Question: Write the caption for this figure.
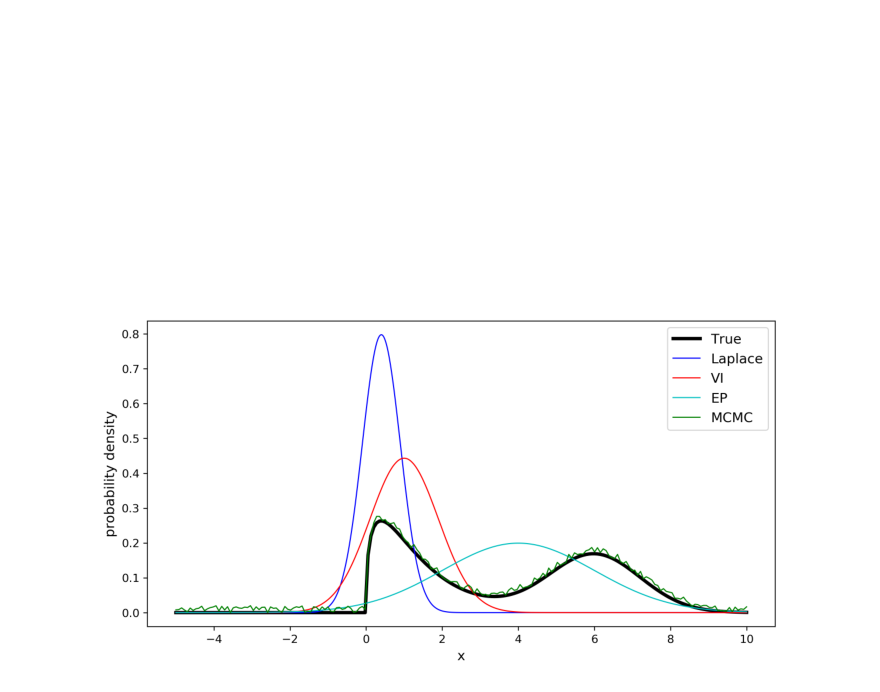
Answer: Approximate Bayesian inference techniques. The Laplace approxi- mation aligns with the peak. Variational inference (VI) typically aligns with one of the modes of the distribution. In contrast, expectation propagation (EP) considers the average over all modes, resulting in a more dispersed distribution. Markov Chain Monte Carlo (MCMC) can theoretically obtain the exact distri- bution if finitely many samples are taken.